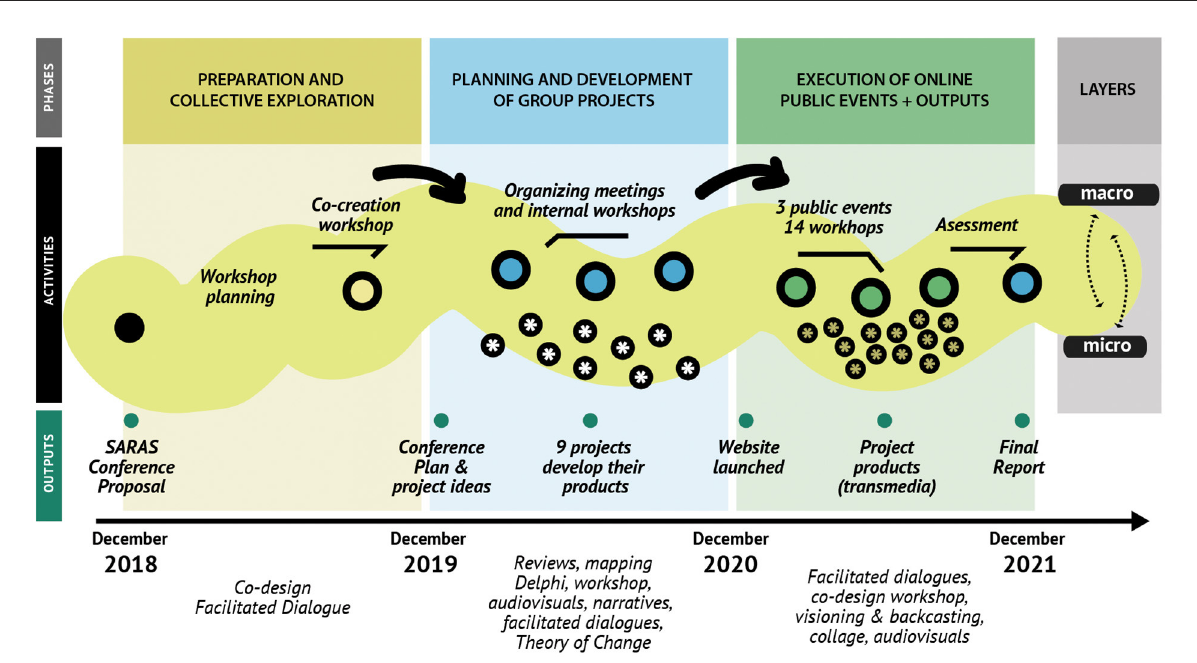
FIGURE1 Visual outline of the evolution of the process and its phases between 2018 and 2021. This graphic shows the activities, outputs, and methods (below) adopted. It also highlights the two analytical layers used (macro and micro).